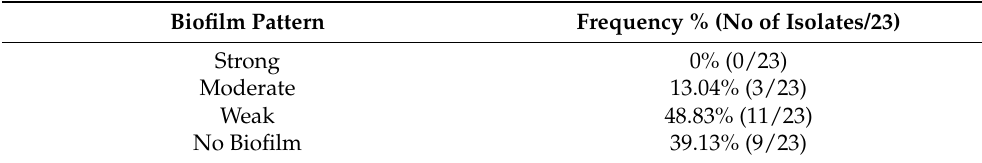
Table 2. The frequency of carbapenemase-resistant K. pneumoniae isolates forming biofilm ( n =